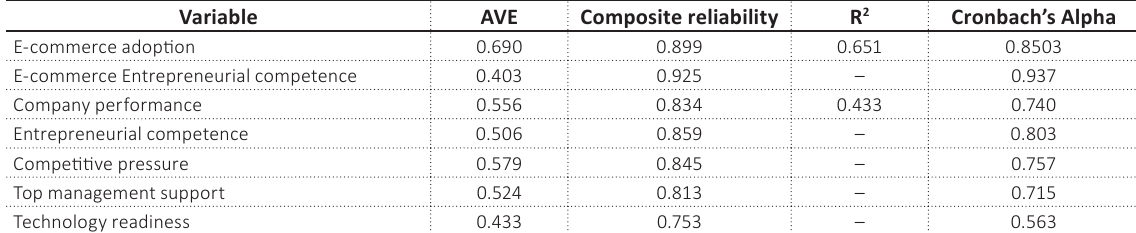
Table 2. Quality criteria